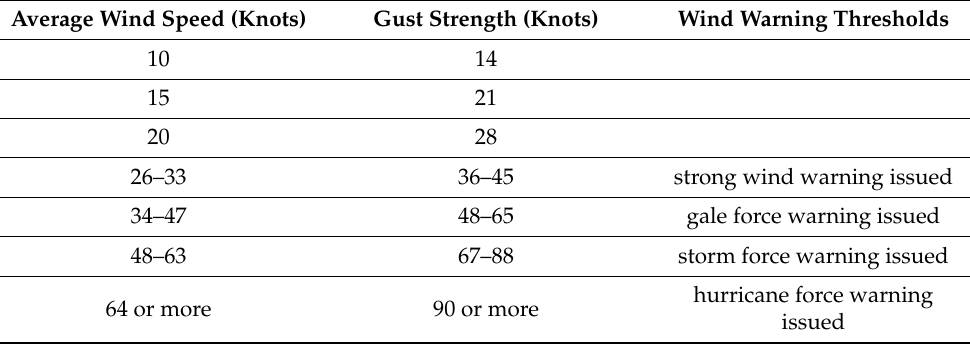
Table 11. Wind speeds, gusts, and associated wind warning